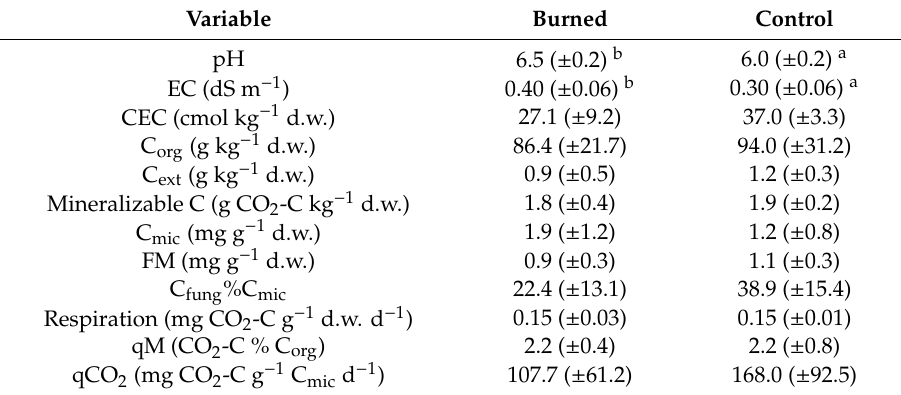
Table 1. Mean values ( ± standard deviations) of soil pH, electrical conductivity (EC), cation exchange capacity (CEC), organic carbon (C org ), extractable organic C (C ext ), mineralizable C content, microbial biomass (C mic ), fungal mycelium (FM), fungal percentage of C mic (C fung %C mic ), respiration, quotient of mineralization(qM),andmetabolicquotient(qCO 2 ), intheburnedandcontrolplots. Significant( p < 0.05) di ff erences between treatments (determined by t -test), for each variable are indicated by di ff erent letters in